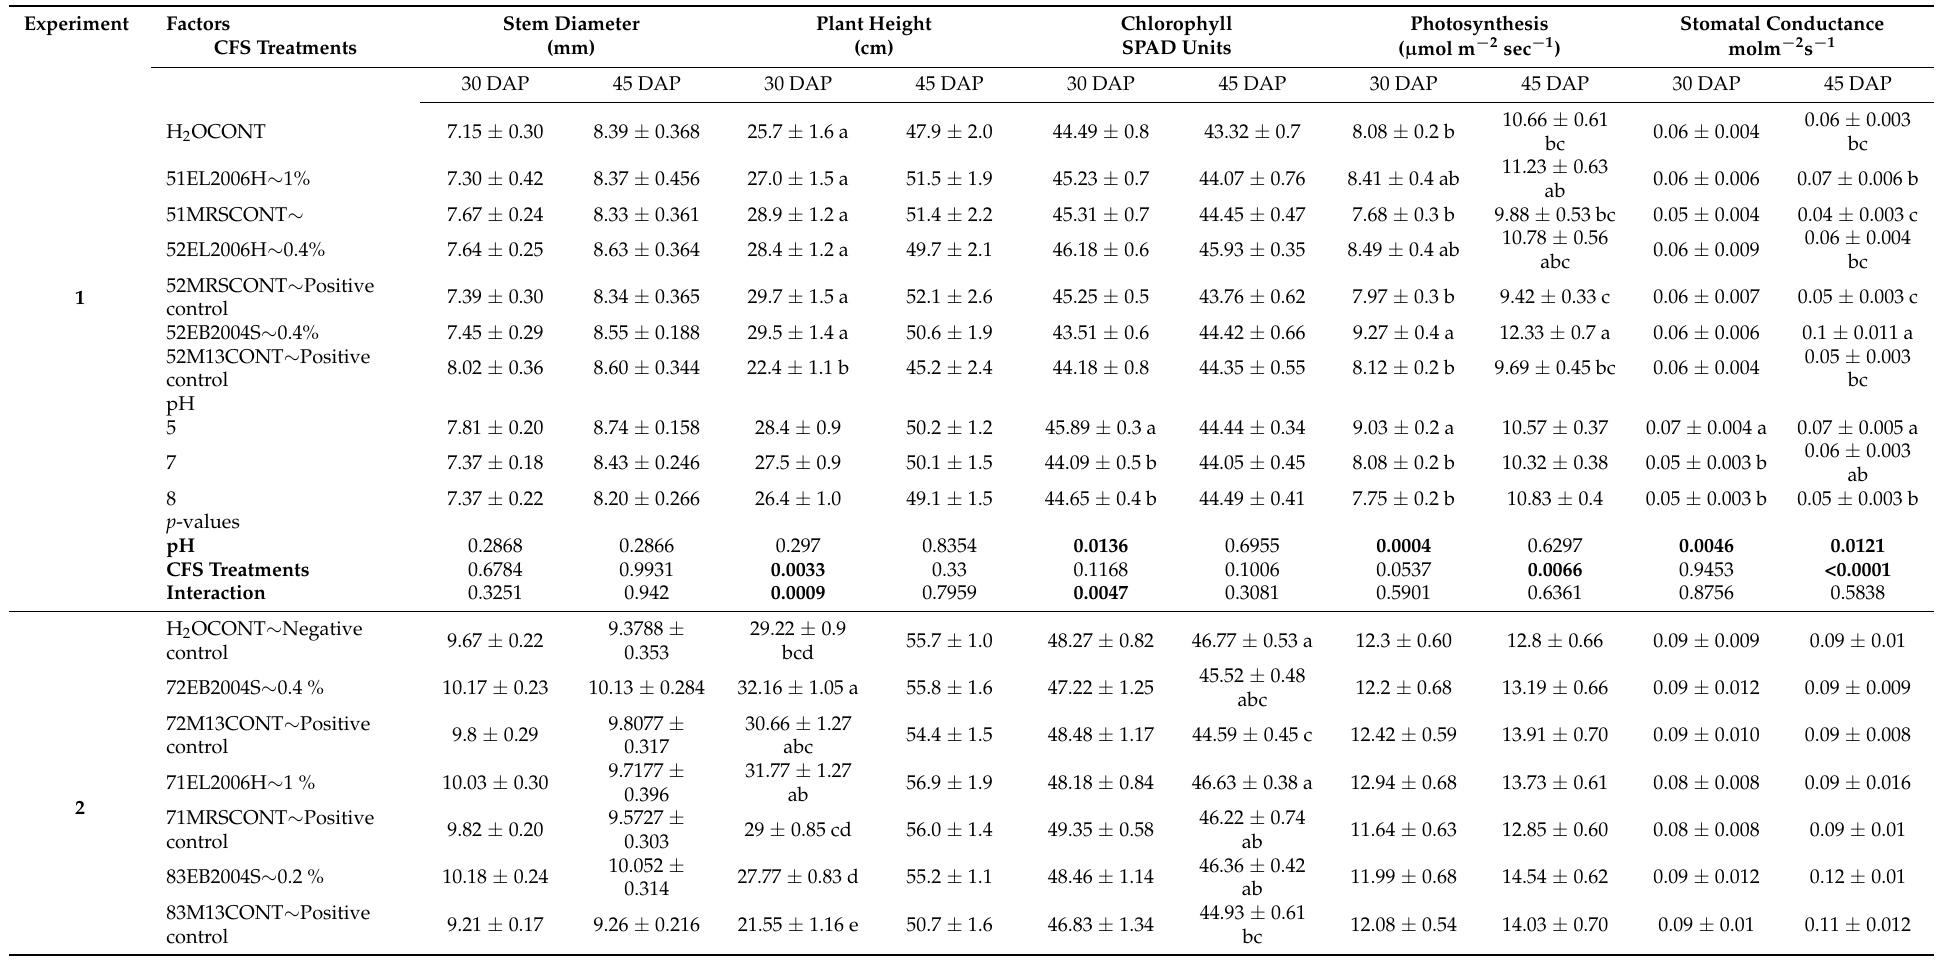
Table 1. A two-way ANOVA on the response of potato to CFS and pH treatments on selected growth (stem diameter and plant height) and physiological (chlorophyll, photosynthesis, and stomatal conductance) variables under greenhouse conditions. Experiment 1 represents CFS treatments obtained at pH 5; Experiment 2 represents CFS treatments obtained at pHs 7 and